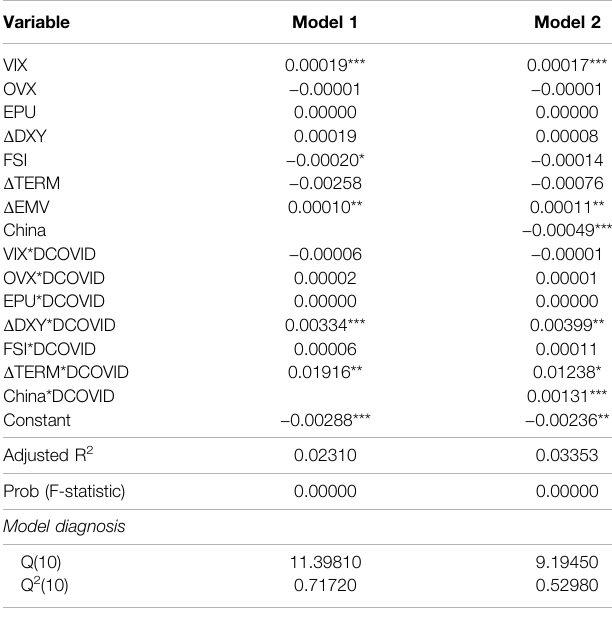
TABLE 5 | Drivers of return equicorrelation — OLS regression and COVID-19 interaction